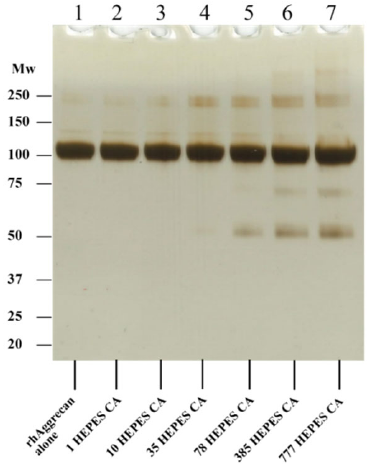
Figure 5. Effects of HEPES chloramines on rhAggrecan. HEPES chloramines (HEPES-CA) were pre- pared and assayed as described in Section 2 and [58]. rhAggrecan (643 nM) was then incubated with HEPES-CA at molar excesses of 0, 1-, 10-, 35-, 78-, 385-, and 777-fold molar excess over rhAggrecan (i.e., 0, 0.7, 7, 25, 50, 247 and 500 µ M) for 24 h at 37 ◦ C in PBS. The samples were then subjected to SDS-PAGE separation under reducing condition, with the protein bands subsequently visualized by silver staining. A representative image from three independent experiments is presented. Molecular mass markers are indicated on the left side of the image.